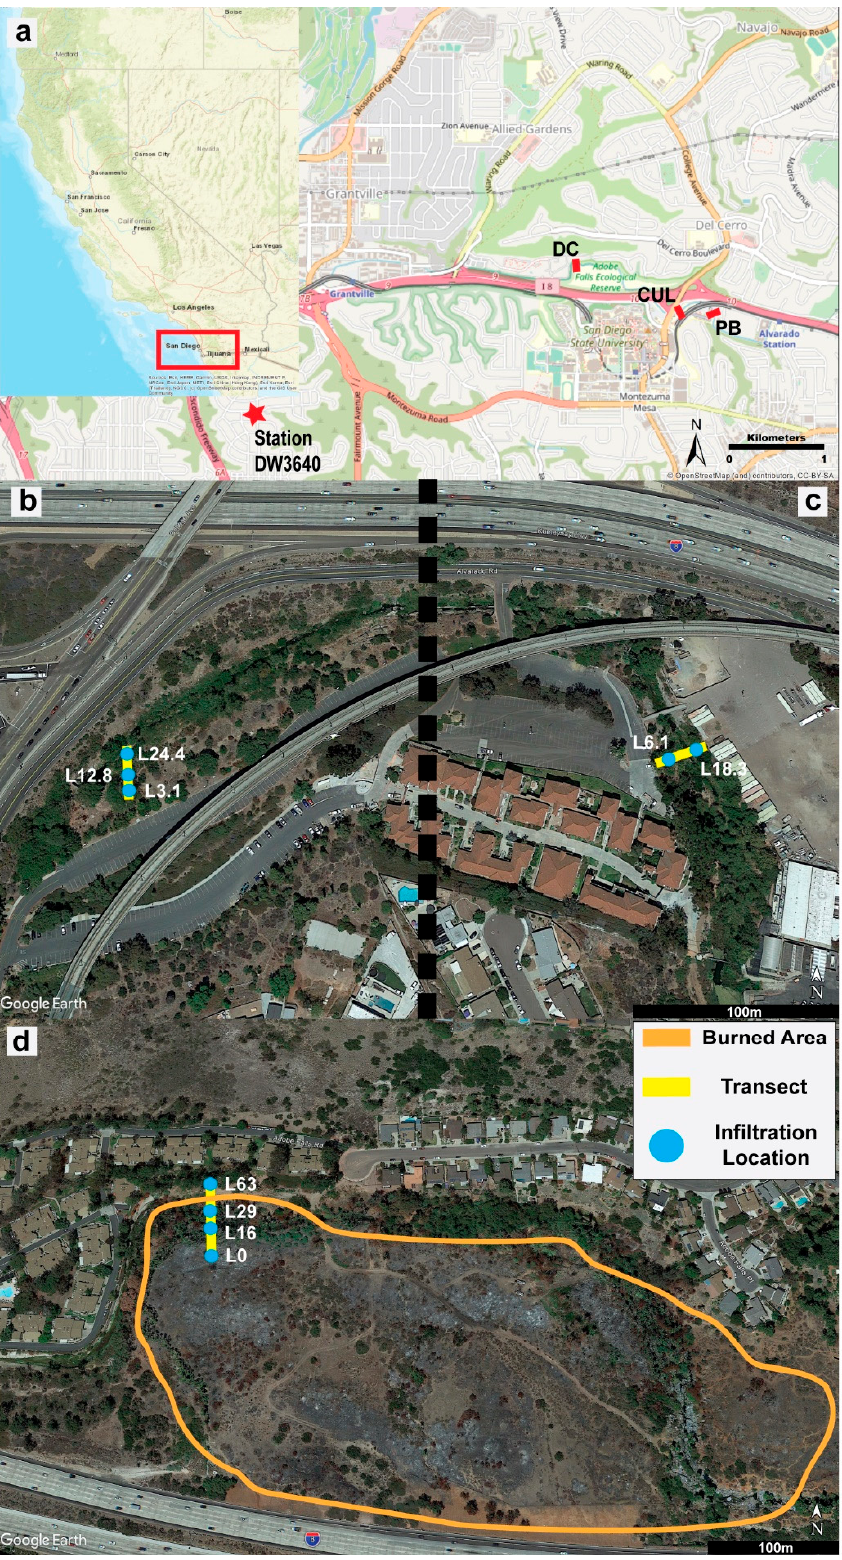
Figure 1. Location of transects at Alvarado Creek in San Diego, California, and the Citizen Weather Program Station DW3640 ( a ). Aerial overviews of the unburned culvert (CUL, b ), unburned pedestrian bridge (PB, c ), and Del Cerro (DC, d ) transects. The infiltration, soil moisture, and soil sample locations are noted, and the Del Cerro fire perimeter is delineated in orange.